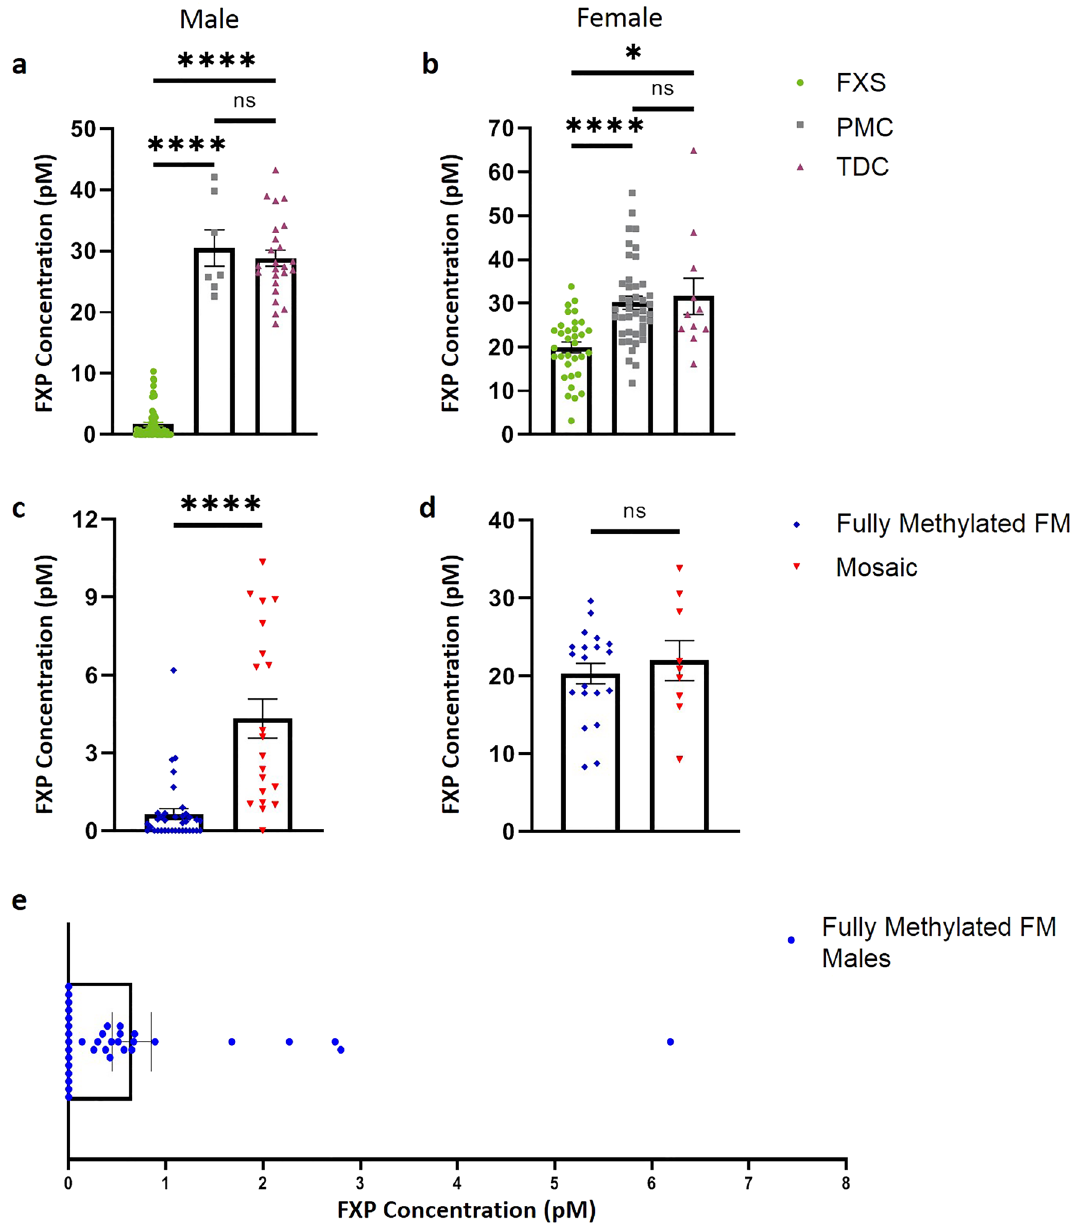
Figure 5. FXP concentration is reduced in males and females with FXS. ( a ) Males with FXS have significantly lower FXP concentrations than PMC and TDC males (Kruskal–Wallis analysis with Dunn’s multiple comparisons; H(3) = 64.40 , p (FXS vs PMC) < 0.0001, p (FXS vs TDC) < 0.0001). In our sample, there is no significant difference between FXP concentrations in PMC and TDC males (Kruskal–Wallis analysis with Dunn’s multiple comparisons; H(3) = 64.40 , p > 0.9999). ( b ) Females with FXS had significantly lower FXP than PMC and TDC females (Kruskal–Wallis analysis with Dunn’s multiple comparisons; H(3) = 22.12, p( FXS vs PMC ) < 0.0001, p( FXS vs TDC ) = 0.0101). There was no significant difference between female PMC and TDC (Kruskal–Wallis analysis with Dunn’s multiple comparisons; H(3) = 22.12, p > 0.9999). Note that data shown